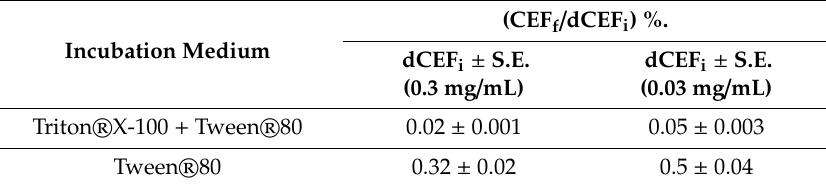
Table 1. Percentage of CEF hydrolysis in presence of 5 U of esterase porcine